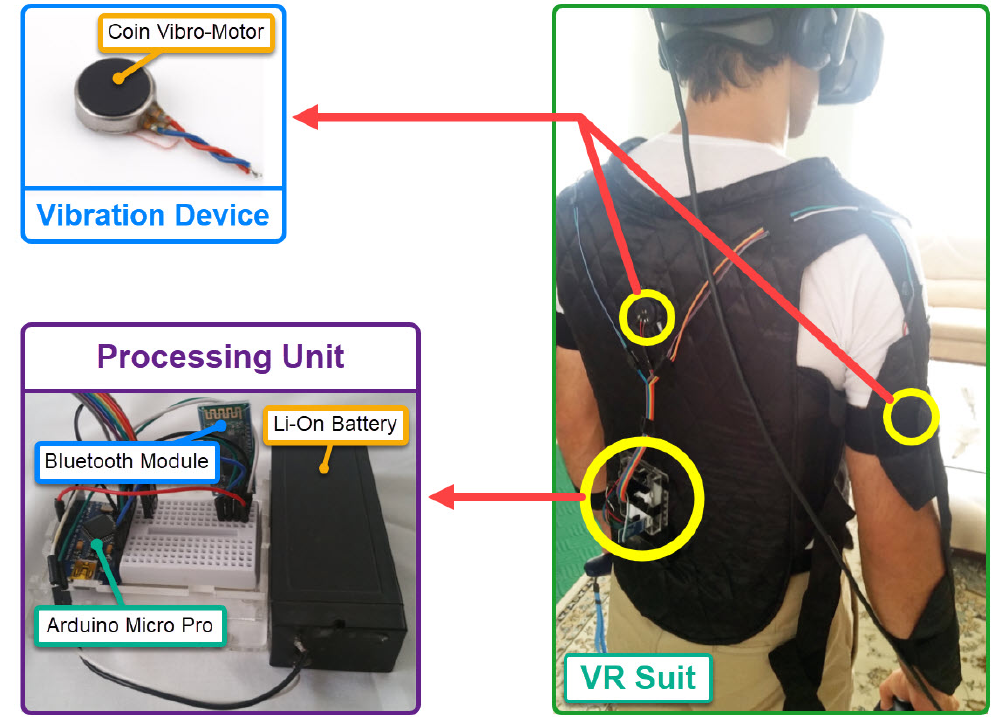
Figure 2. The prototype version of our proposed VR